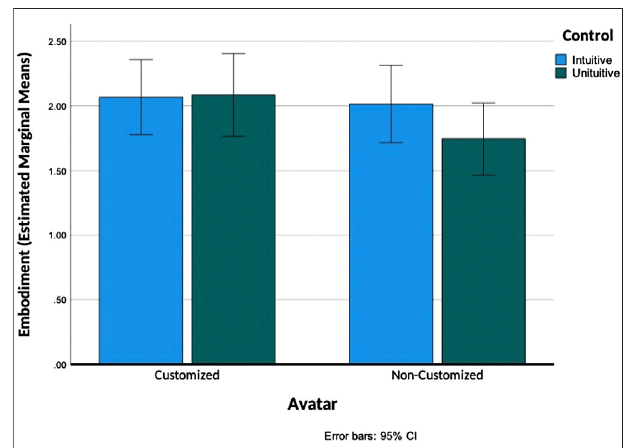
FIGURE 6 | Estimated marginal means of